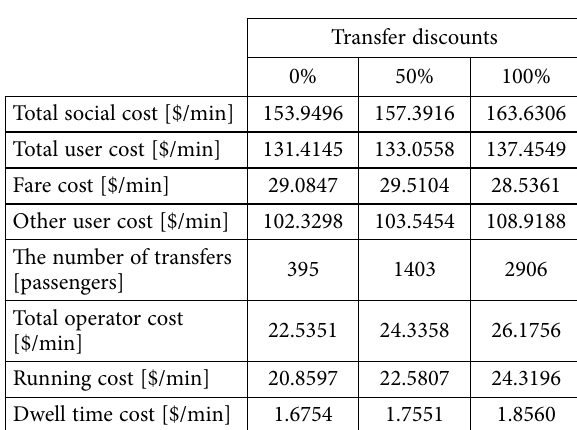
Table 4. The results of different transfer discounts with a 0.5 multiplier of basic bus